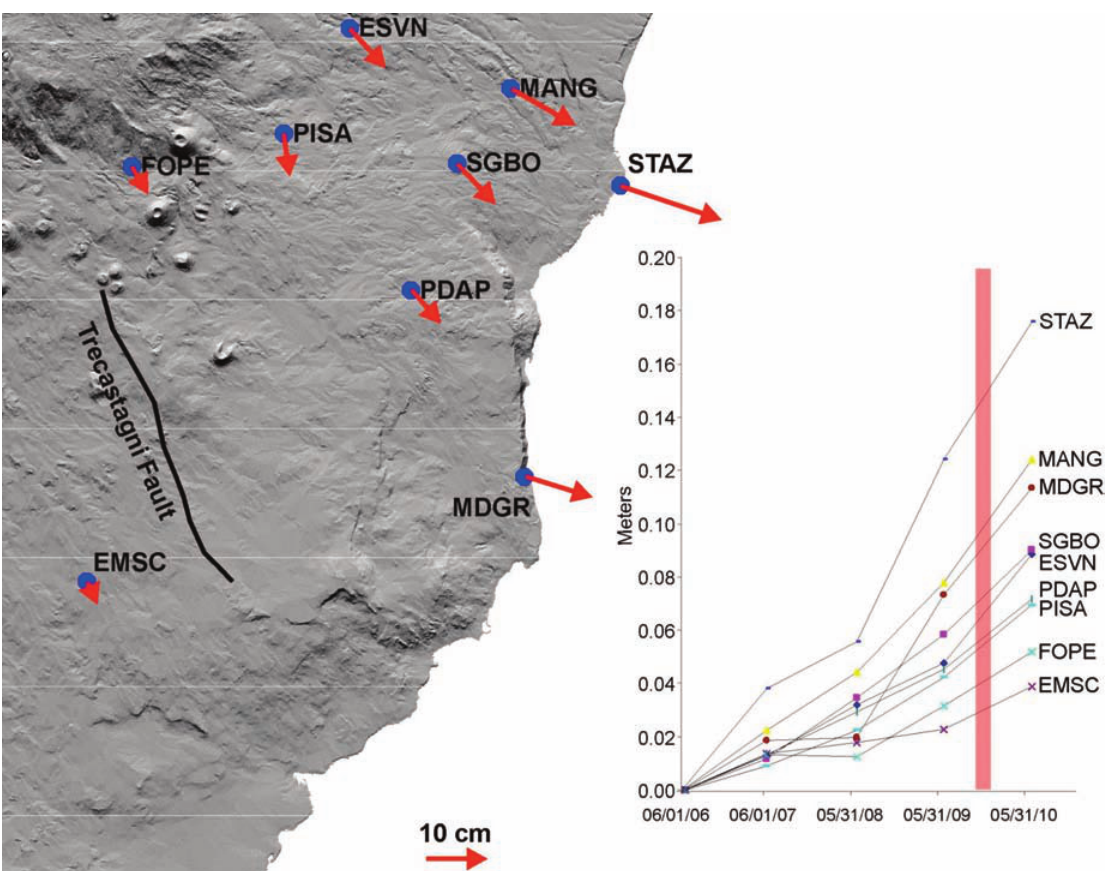
Figure 9. Global positioning system horizontal measurements between June 2006 and June 2010; arrows indicate the amplitude and direction of the displacements, and the graph shows the time series of the displacements. The red bar indicate the October 2009–January 2010